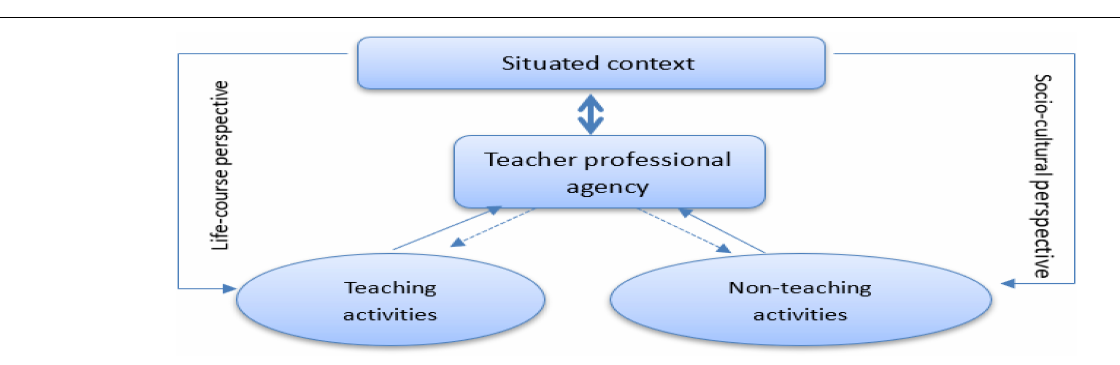
FIGURE 2 | Conceptual framework of EFL-speaking instructors’ enactment of teacher